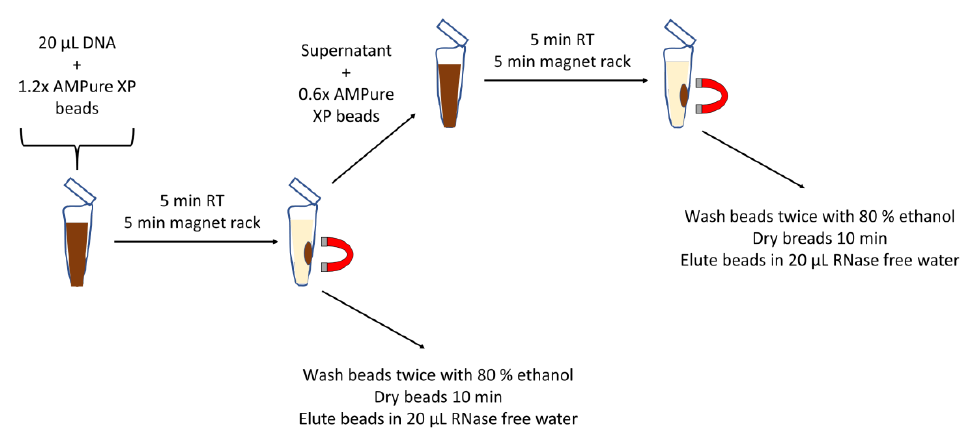
Figure 4. Purification procedure for the isolation of ctDNA from contaminated plasma DNA samples. Contaminated plasma DNA was mixed with AMPure XP magnetic beads, incubated and high molecular DNA bound to the magnetic beads were isolated. The pellet containing the high molecular DNA was washed twice with 80% ethanol, air-dried and the DNA was eluted with 20 µL RNase free water. Magnetic beads were added to the supernatant (0.6× volume of supernatant), incubated, pelleted on a magnetic rack. Washing, drying and elution of the ctDNA was done similarly. With this protocol we selectively purified DNA fragments with a size of 90–250 bp from the